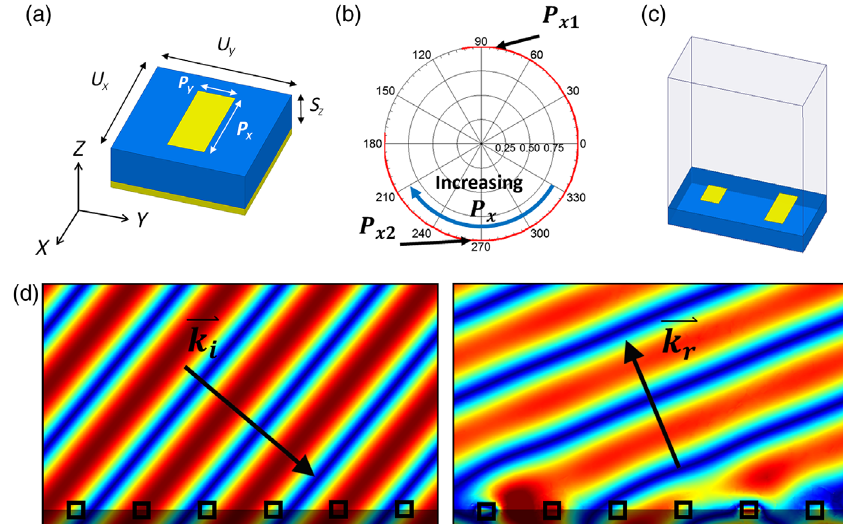
Λ /2, U x ¼ y ¼ is varied. The chosen x